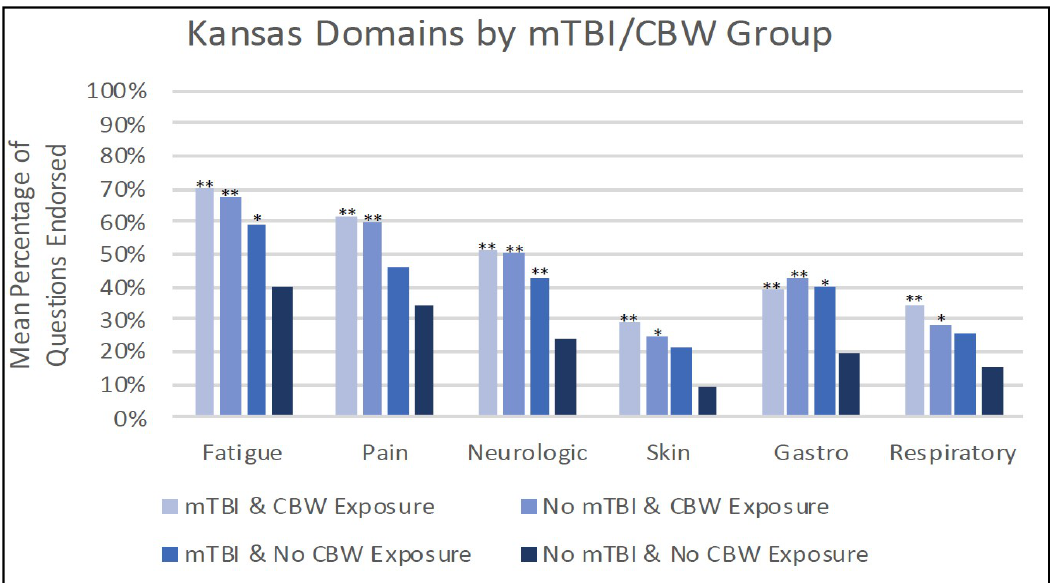
Figure 2. Kansas symptom domains by mTBI and CBW groups. * p < 0.05, ** p < 0.005 for comparison with reference group (no mTBI & no CBW exposure), mTBI = mild traumatic brain injury, CBW = chemical/biological weapons.